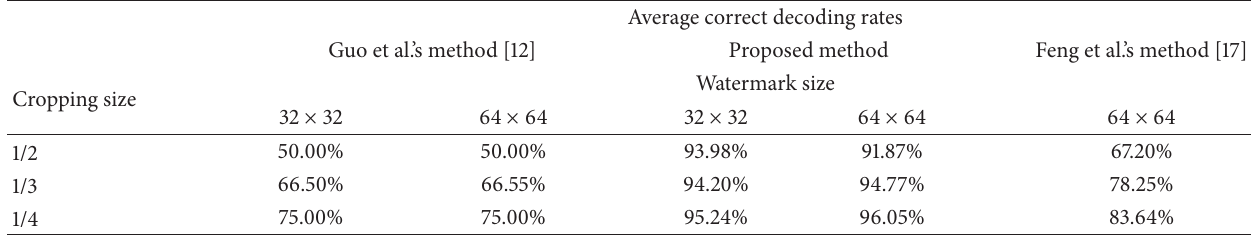
Table 9: Average correct decoding rates of different cropping size.